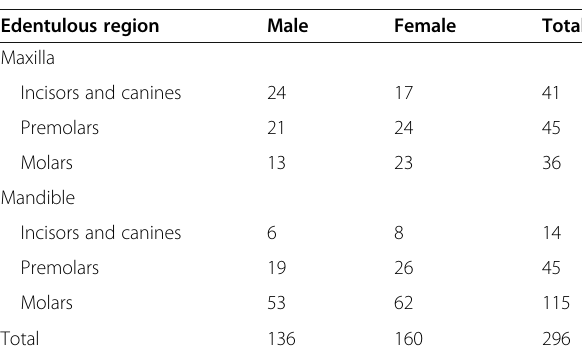
Table 1 Location and sex distribution of edentulous regions studied